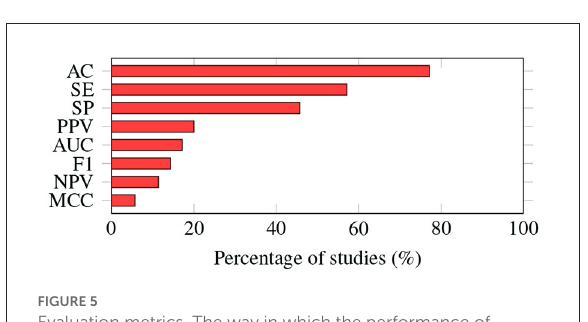
FIGURE5 Evaluation metrics. The way in which the performance of machine learning algorithms is evaluated varies from study to study. Accuracy is the most common metric; it was adopted by almost 80% of the studies. AC, accuracy; SE, sensitivity; SP, specificity; PPV, positive predictive value; AUC, area under the ROC curve; F1, F1-score; NPV, negative predictive value; MCC, Matthews correlation